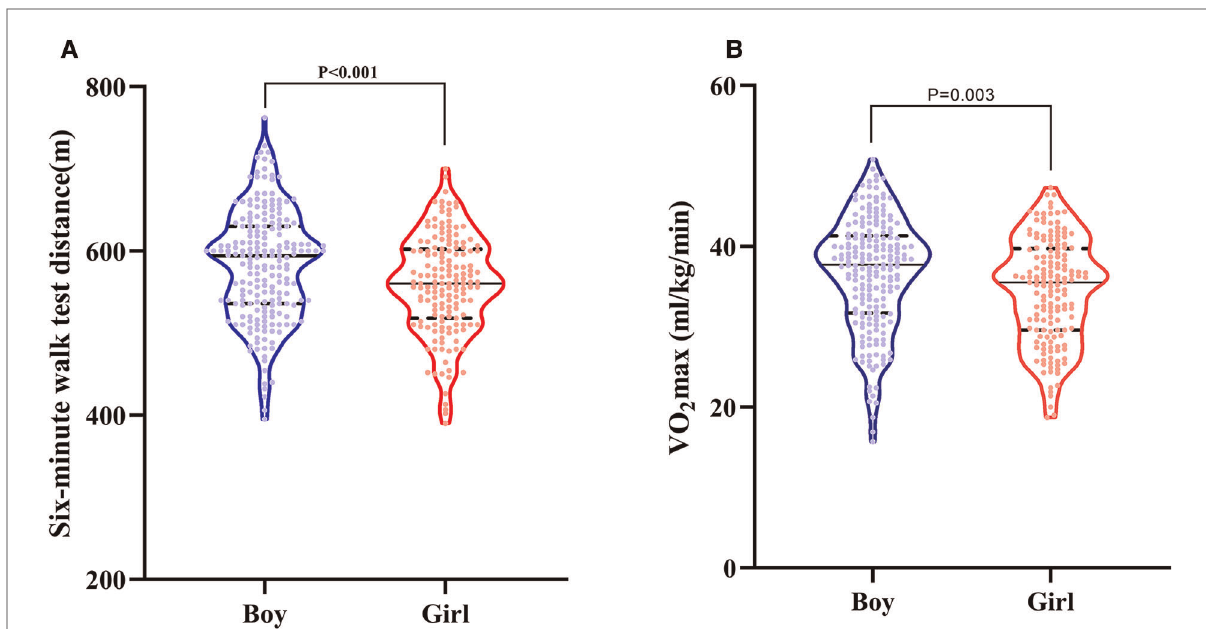
FIGURE 1 Violin diagrams of the distribution of six-minute walk test (6MWT) distance by gender ( A ); violin diagrams of the distribution of VO 2 max by gender ( B ). The upper and lower dashed lines represent the fi rst and third quartiles, and the solid line in the middle represents the median.